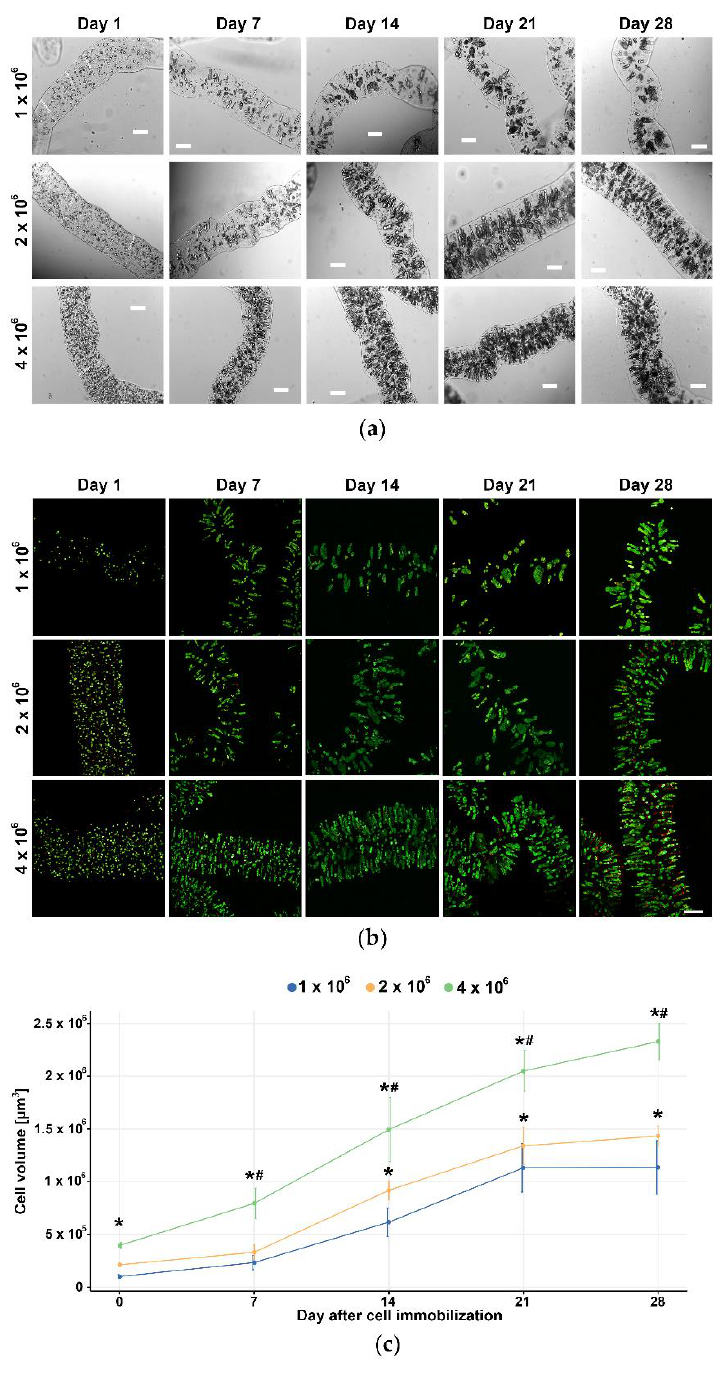
Figure 3. Selection of the optimal cell density for long-term 3D culturing. ( a ) Brightfield light microscopy and ( b ) confocal microscopy of three different U87 cell inoculation densities (1 × 10 6 cells, 2 × 10 6 cells, and 4 × 10 6 cells per 1 mL of 2% w / w alginate) in long-term 3D cell culture at different time points (day 1, 7, 14, 21, and 28). Merged channels show live cells labeled with CAM (green) and dead cells labeled with PI (red). ( c ) ImageJ software was used to calculate the cell volume in alginate fibers as an indirect measure of cell number. Scale bar = 200 µm. All values are expressed as mean ± SD ( n ≥ 3). * indicates p < 0.05 statistical difference compared to the 1 × 10 6 cells inoculation densities. # indicates p < 0.05 statistical difference compared to the 2 × 10 6 cells inoculation densities.